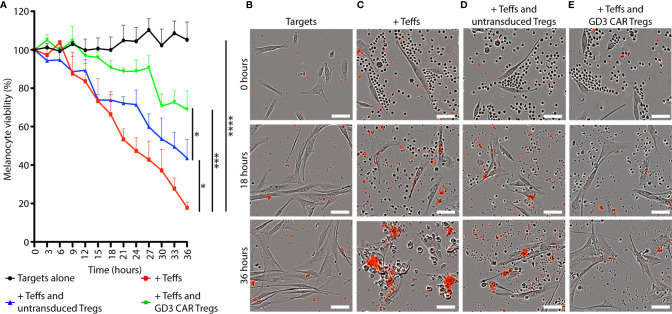
GD3 CAR Tregs provide melanocytes with superior protection from T cell-mediated cytotoxicity in vitro. The immunosuppressive ability of GD3 CAR Tregs and untransduced Tregs was compared in vitro.
(A) Viability of HLA-A2+ human melanocytes (targets) in the presence or absence of murine Teffs and Tregs (1:10:1) is represented over time. Representative images of (B) HLA-A2+ human melanocytes (C) combined with murine Teffs, and additionally with (D) murine untransduced Tregs, or (E) GD3 CAR Tregs. Dead cells are marked by a red precipitate formed by caspase activity. Statistical significance was determined by two-way ANOVA with aligned rank transformation followed by Tukey’s pairwise multiple comparisons test. *p < 0.05; **p < 0.01; ***p < 0.001; ****p < 0.0001 (Scale bar = 50μm).